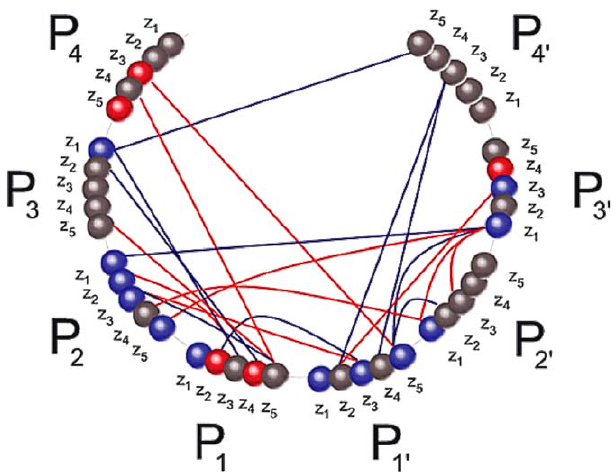
Figure 3. Map of Physicochemical Properties of Retroviral Protease Substrates Based on the Regression Coefficients of Substrate and Substrate–Substrate Cross-Terms of the